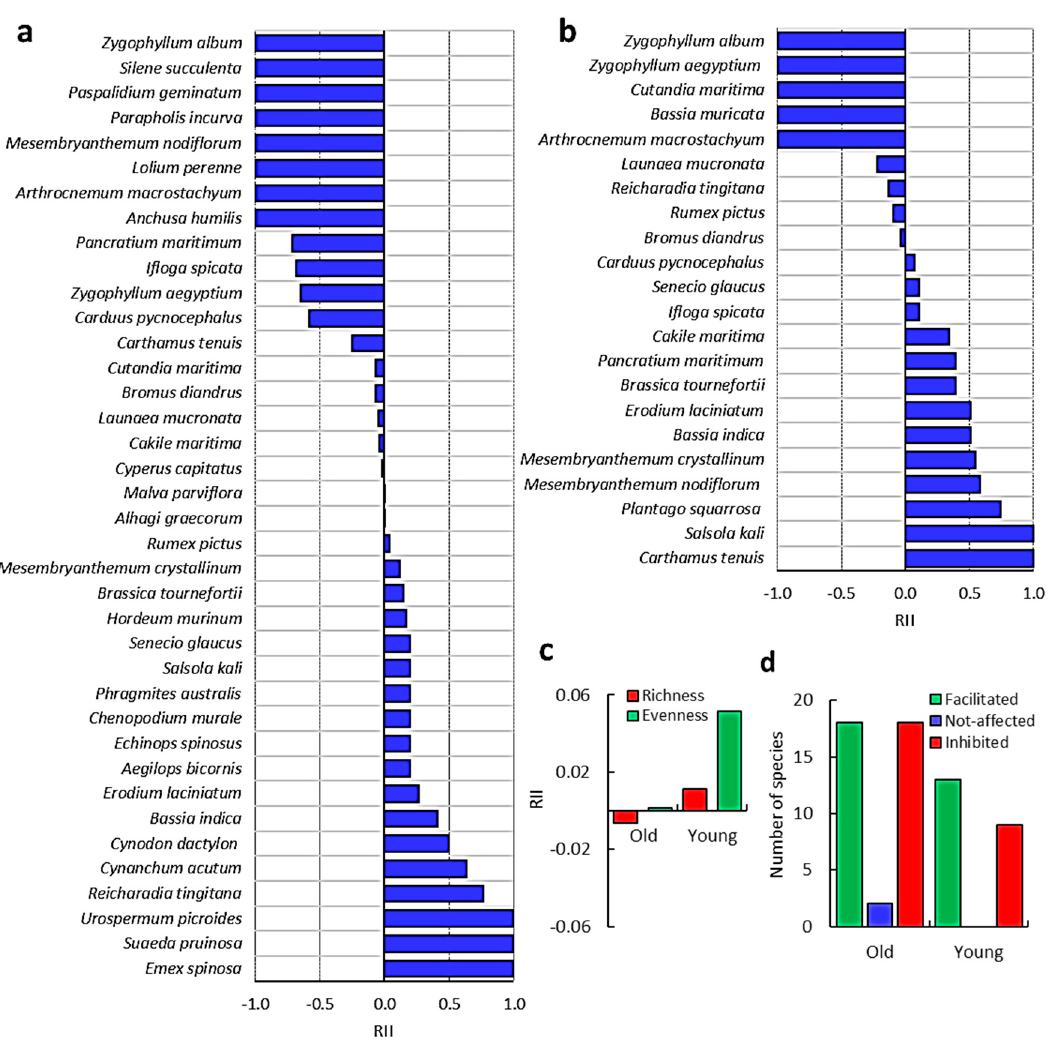
Figure 2. Interference of C. polygonoides shrubs with the associated species. ( a ) Relative interaction index (RII) of the associated species with old shrubs. ( b ) RII of the associated species with young shrubs. ( c ) RII of C. polygonoides shrubs on the associated species richness and evenness. ( d ) Number of facilitated, inhibited or not-affected associated species.